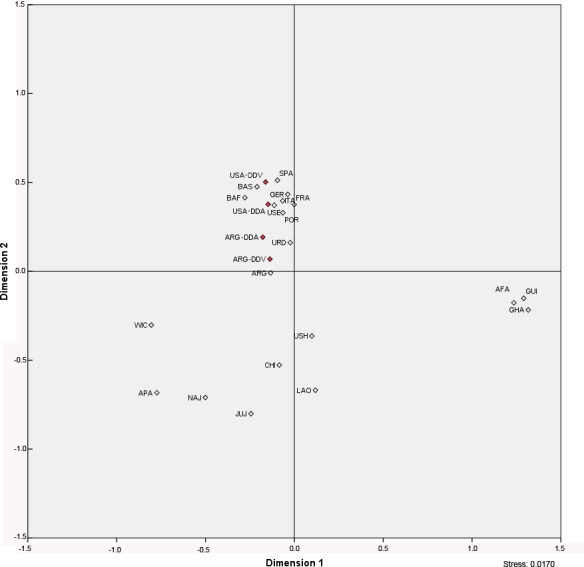
MDS showing distances between Basque Diaspora populations and other populations, based on mtDNA haplogroup frequencies.Populations included are as follows: Basque Diaspora populations (in red) from USA (USA-DDV and USA-DDA) and Argentina (ARG-DDV and ARG-DDA); Basque populations from Spain (BAS) and France (BAF); France (FRA); Germany (GER); Italy (ITA); Portugal (POR); Spain (non-Basque included) (SPA); African American (AFA), Apaches (APA), Navajos (NAJ), Hispanos (USH), and European descents (USE) from USA; Jujuy (JUJ), and residents (ARG) from Argentina; Basque Diaspora from Uruguay (URD); South-West China (CHI); Laos (LAO); Guinea-Bissau (GUI); and Ghana (GHA).